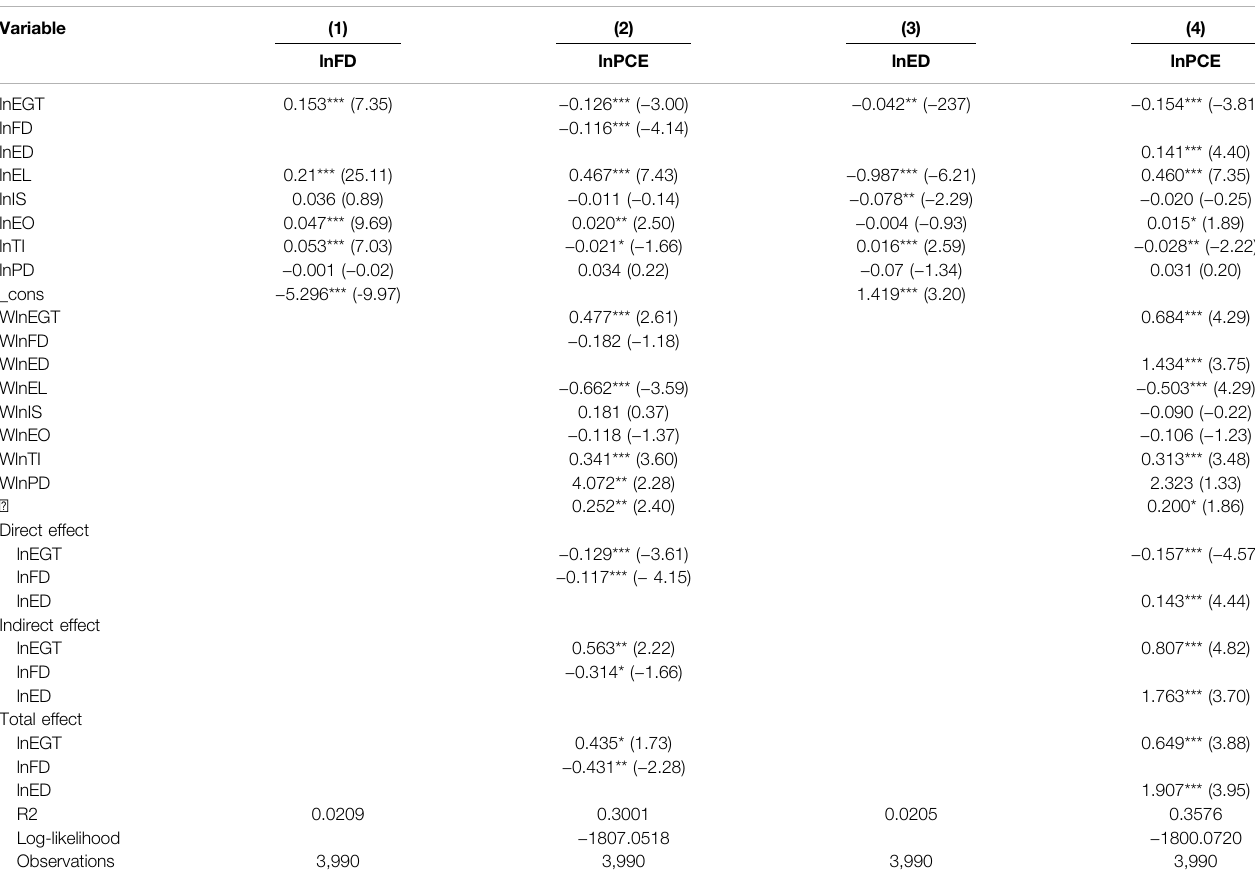
TABLE 8 | Mediation effect results.